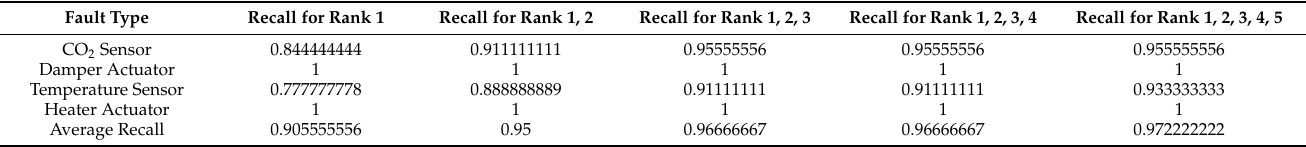
Table 26. Recall of diagnostic classifier in different cumulative ranks for different fault